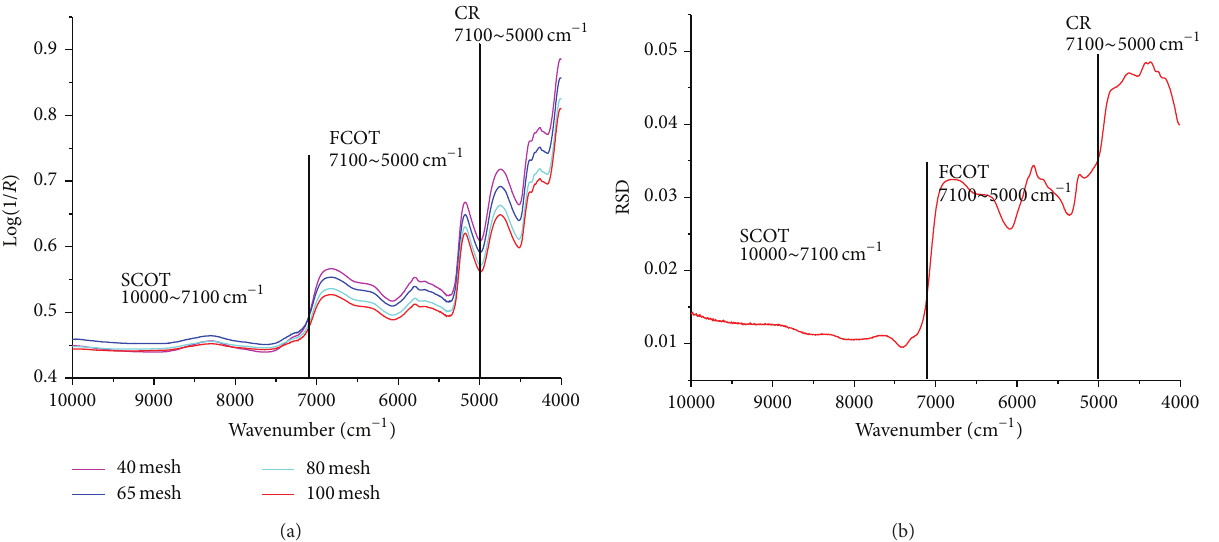
Figure 2: (a) Raw spectra of samples with different granularity. (b) Difference of NIR frequency range to the